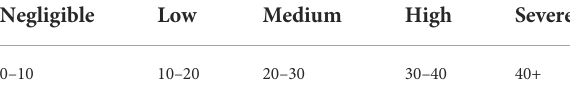
TABLE 2 ESG risk rating scale. Source: Sustainalytics,